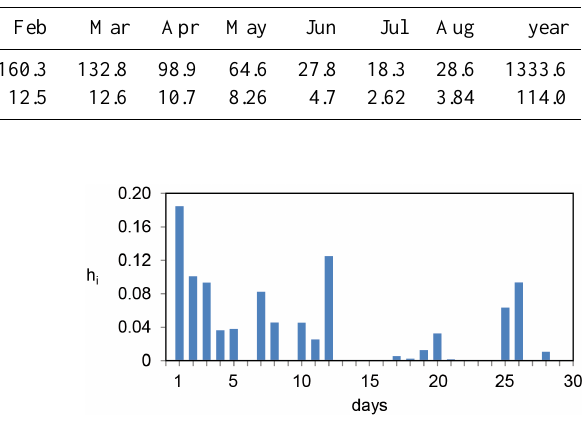
Figure 10. Sorrento Peninsula case study. Average kernel obtained from the 100 best filter